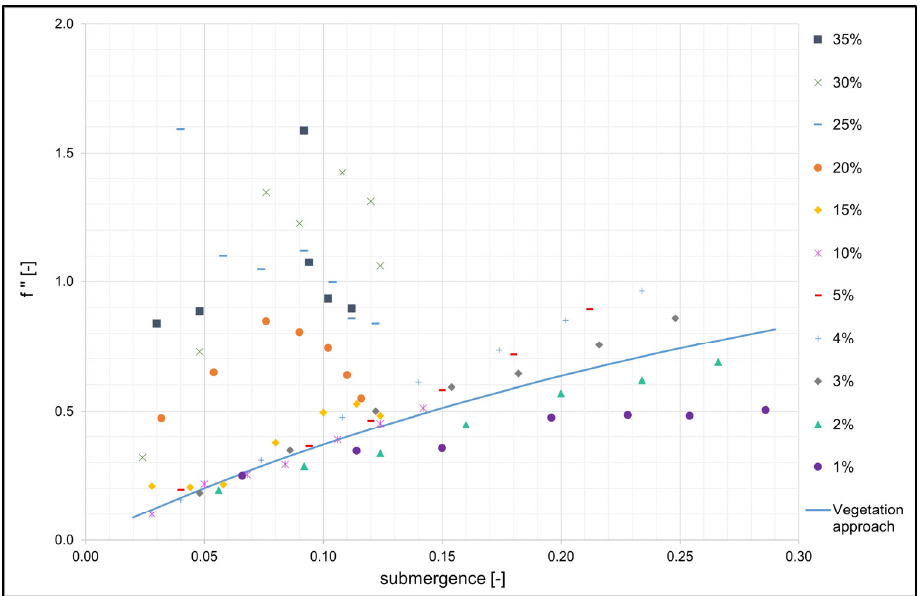
Figure 9. Relationship between submergence ( h/h veg ) and friction factor f ″ for measured values of ex- periments with wheat (dots) in comparison to the vegetation approach (blue, solid line, Equation (3)).